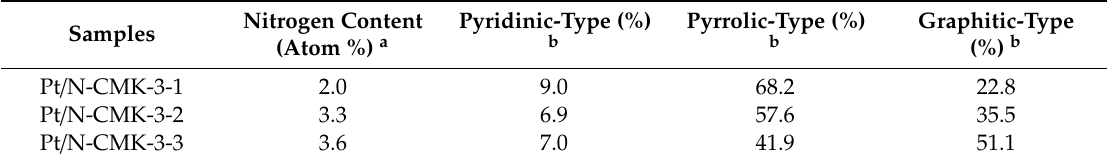
Figure 4. ( a ) Pt 4f XPS spectra of Pt/CMK-3 and Pt/N-CMK-3-x (x = 1, 2, and 3) and ( b ) N 1s XPS spectra of Pt/N-CMK-3-x (x = 1, 2, and 3). Table 2. Relative peak area percentage of each type of N in Pt/N-CMK-3-x catalysts. Table 2. Relative peak area percentage of each type of N in Pt / N-CMK-3-x